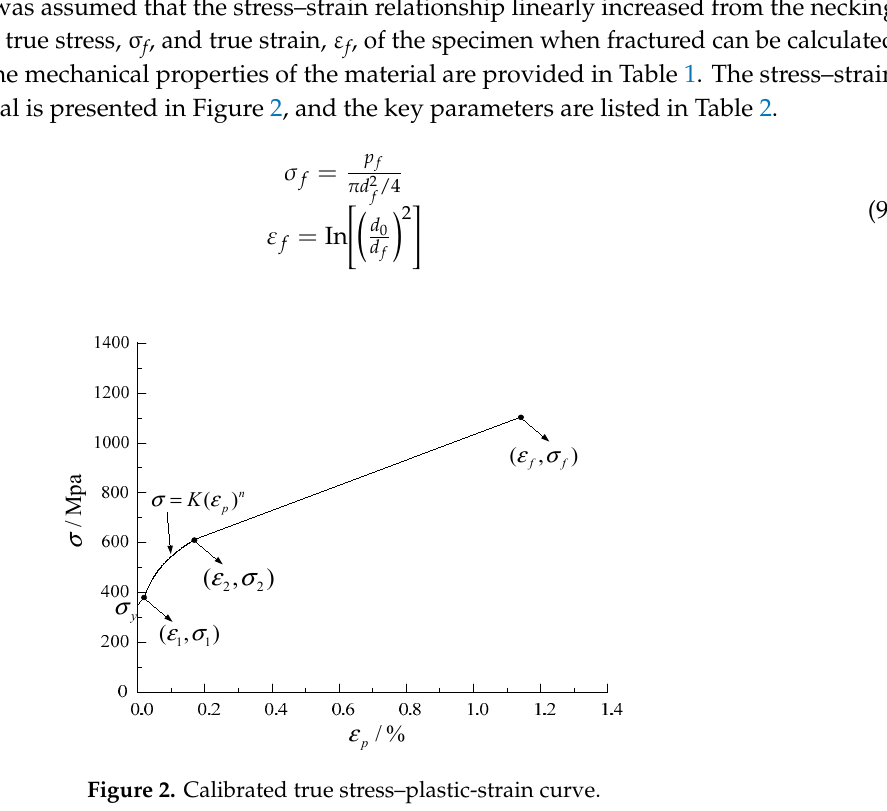
Figure 2. Calibrated true stress–plastic-strain curve. Table 2. Constitutive model parameters under tensile loading.